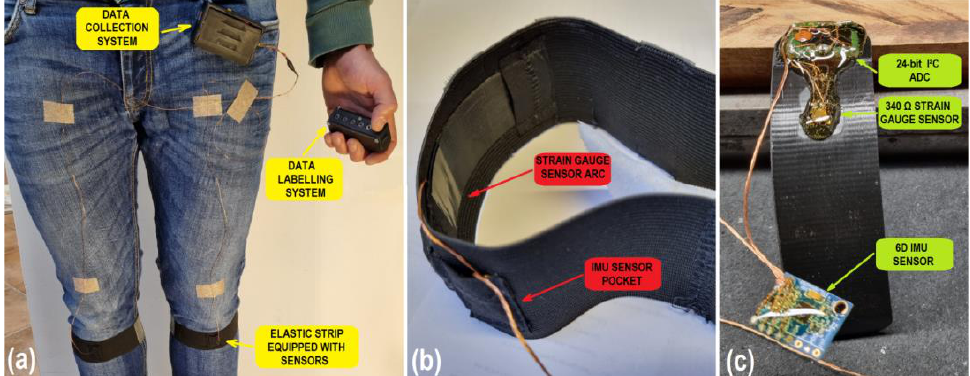
Figure 3. ( a ) Wearing the proposed gait motion data acquisition system; ( b ) close-up picture of the elastic strip equipped with sensors; ( c ) bare sensor unit without the elastic strip. The sensors are covered with elastic glue to increase longevity.